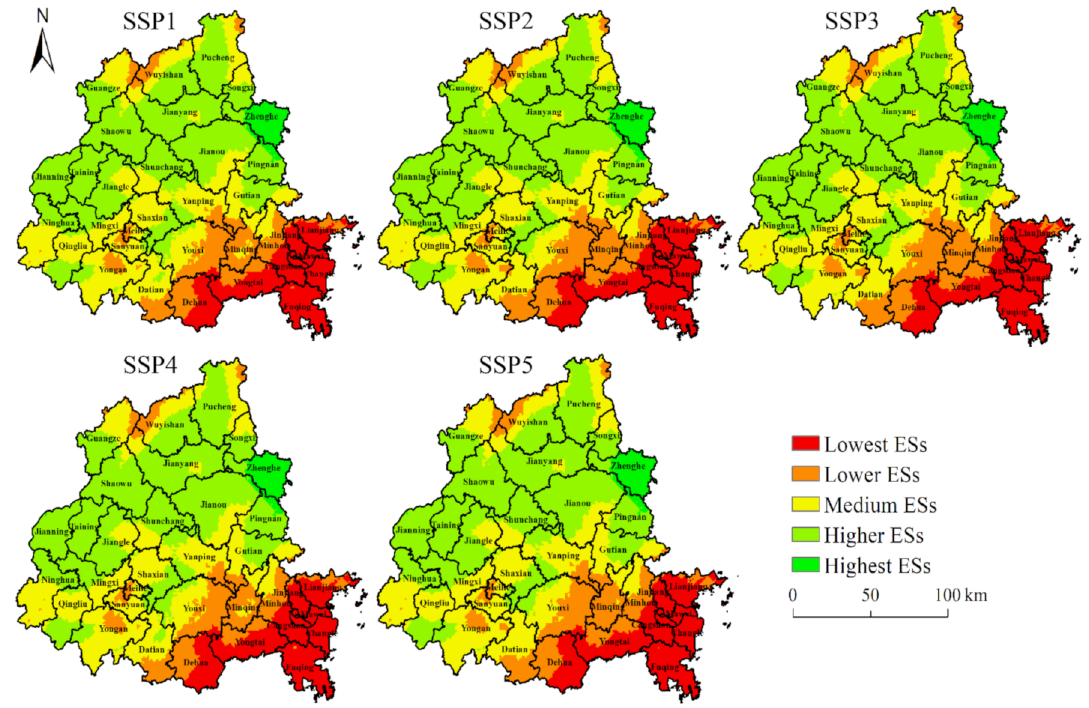
Figure 7. Spatial distribution of ecosystem services in 2030 under SSPs